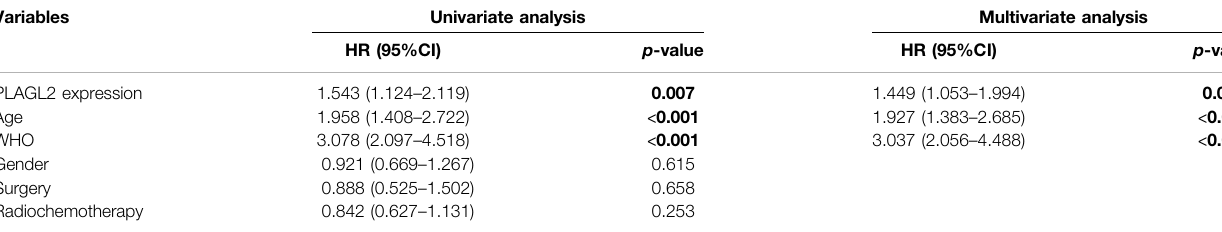
TABLE 4 | Univariate and multivariate Cox proportional hazards analysis of PFS in HGG